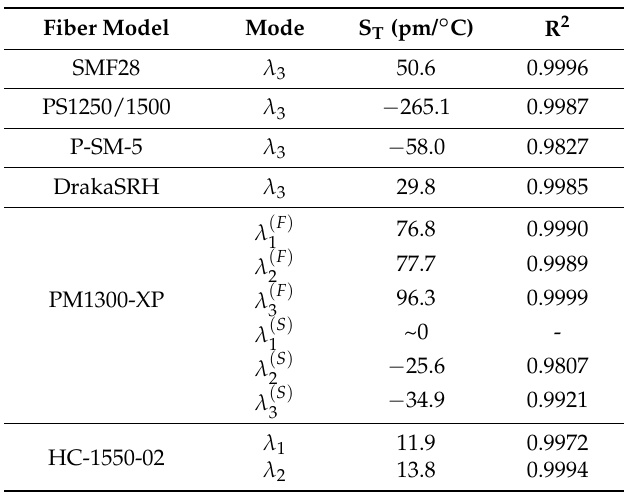
Table 2. Temperature sensitivity of LPGs.